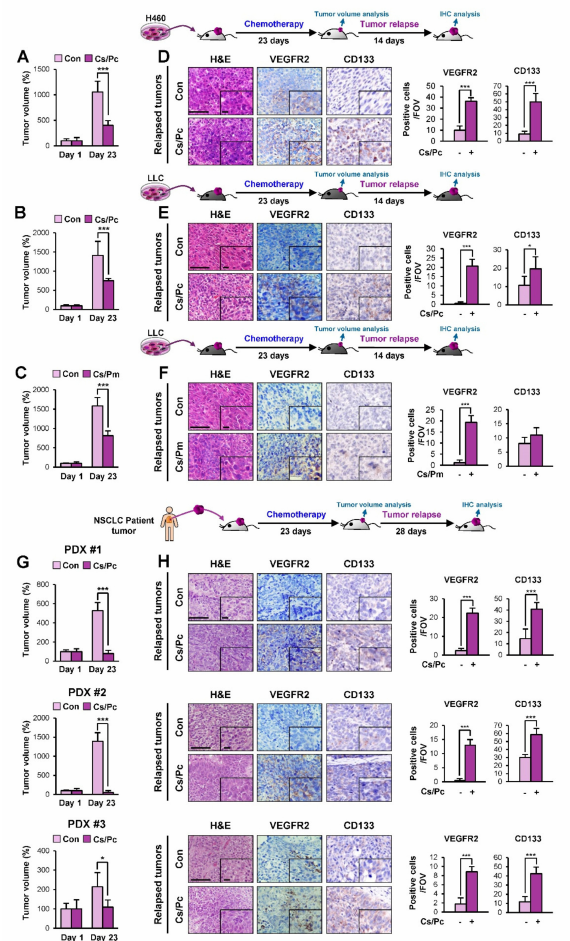
Figure 1. Increased accumulation of vascular endothelial cells in lung tumors derived from those that progressed after chemotherapy in vivo. ( A–C, G ) Changes in tumor growth in mice bearing H460 xenograft tumors (Con: n = 4; Cs / Pc: n = 5) ( A ), LLC allograft tumors [( B ) Con: n = 8; Cs / Pc: n = 12; ( C ) Con: n = 8; Cs / Pm: n = 9], and lung patient-derived xenograft (PDX) tumors derived from three di ff erent non-small-cell lung cancer (NSCLC) patients [PDX #1 (Con: n = 8; Cs / Pc: n = 4); PDX #2 (Con: n = 6; Cs / Pc: n = 6); PDX #3 (Con: n = 6; Cs / Pc: n = 5)] ( G ) subjected to three cycles of combinatorial chemotherapy (each cycle consists of treatment with paclitaxel (Pc; 20 mg / kg) and cisplatin (Cs; 3 mg / kg) in combination for a day or cisplatin (Cs; 3 mg / kg) and pemetrexed (Pm; 50 mg / kg) in combination for a day, followed by a drug holiday for 6 days). ( D–F, H ). Immunohistochemistry (IHC) analyses showing the recruitment of vascular endothelial cells (VEGFR2 + ) and endothelial progenitor cells (CD133 + ) in tumors that progressed after chemotherapy. Quantification of cells positive for each marker per field of view (FOV, n = 12 from at least three tumors) is depicted as a graph ( D–F, H ). Scale bar: 50 µ m ( D–F, H ). Scale bar (inset): 10 µ m ( D–F, H ). For all panels, the bars represent the mean ± SD. * p < 0.05 and *** p < 0.001, as determined by two-tailed Student’s t